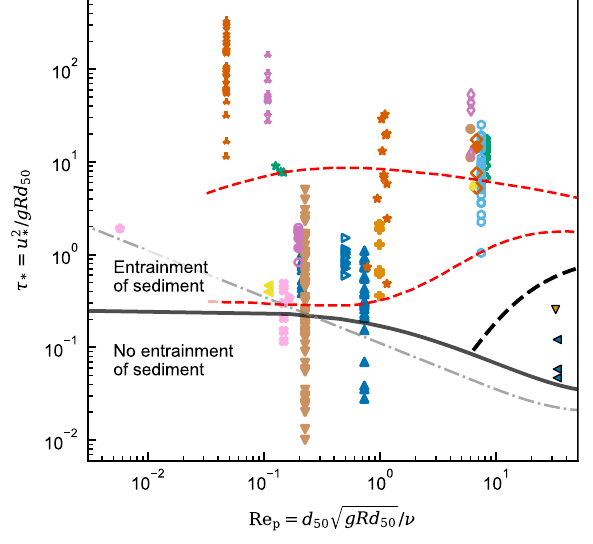
Fig. 2 | Shields diagram. Shields number, τ * , versus the particle Reynolds number, Re p ,ofexperimentalandobservationalgravitycurrentdata(Fig.1).Here, ν denotes the kinematic fl uid viscosity. Solid 32 and dash-dot 60 curves depict the criteria of incipient motion. The black dashed line depicts the w s = u * criterion for suspended load 27 . Equilibrium sediment suspension criteria for monodisperse and poorly- sorted suspensions are depicted by the lower and upper red dashed curves respectively 22 . The symbols and colours are as per Fig.